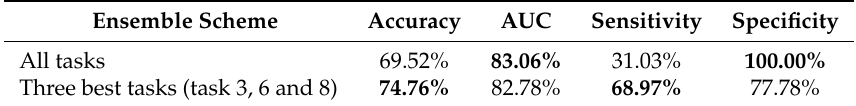
Table 6. Classification performance of the ensemble of tasks. The best results are in bold.